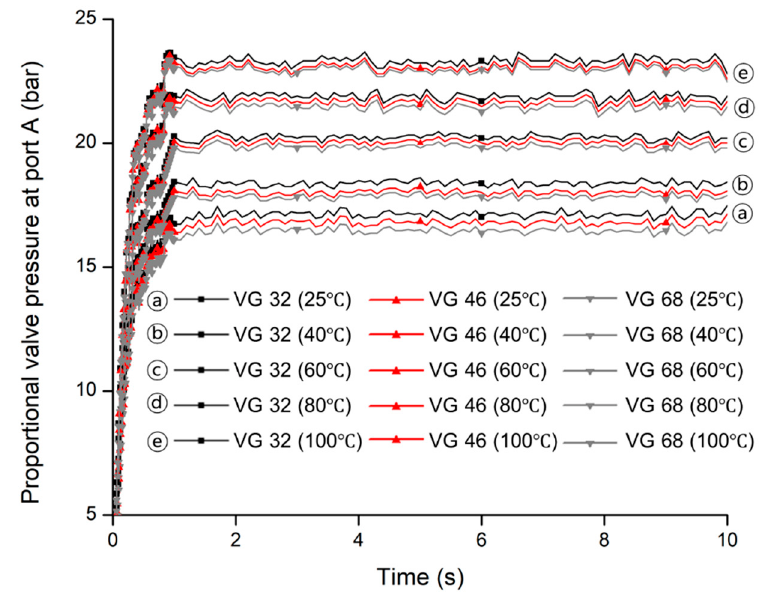
Figure 10. The pressures of the proportional valve at port A for the hydraulic oils measured using test bench at: ( a ) 25 °C; ( b ) 40 °C; ( c ) 60 °C; ( d ) 80 °C; and ( e ) 100 °C.